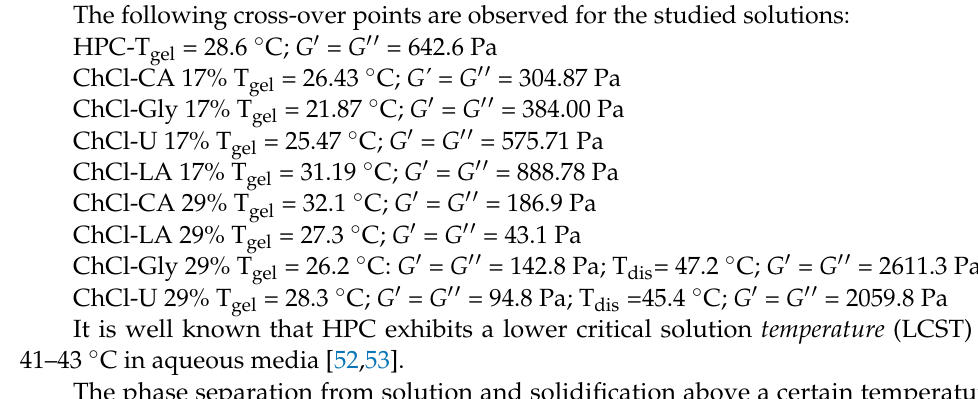
Figure 11. Dynamic moduli, G ′ and G ′′ versus temperature for studied HPC-NADES solutions.